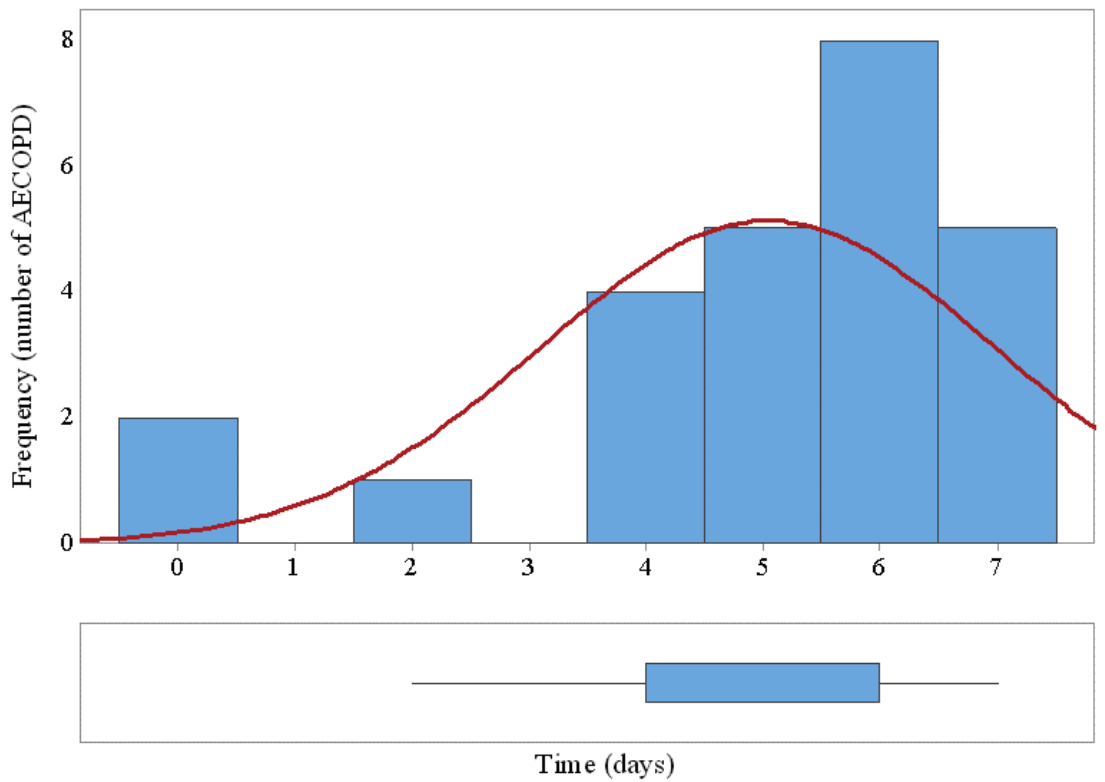
Figure 8. Histogram and box plot of AECOPD prediction margins based on performance of the SVM classifier and the decision rule. The horizontal axe indicates the days of early detection prior to medical